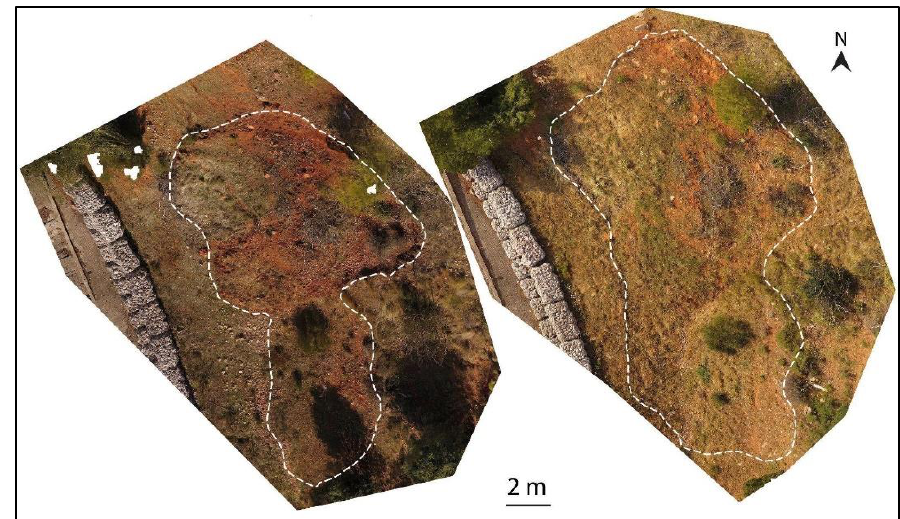
Figure 11. UAV – SfM-derived orthomosaics (map views), showing the differences in the pre-existing landslide dimensions between October 2019 ( left ) and June 2020 ( right ) at the Magoula site. The white dashed line indicates the landslide boundaries, as inferred by the orthomosaic interpretation and fieldwork. Secondary minor cracks were visible in the vicinity of the main scarp, mainly in the southern part. The gabion retaining wall, west of the landslide, was installed shortly before our first visit to the area.